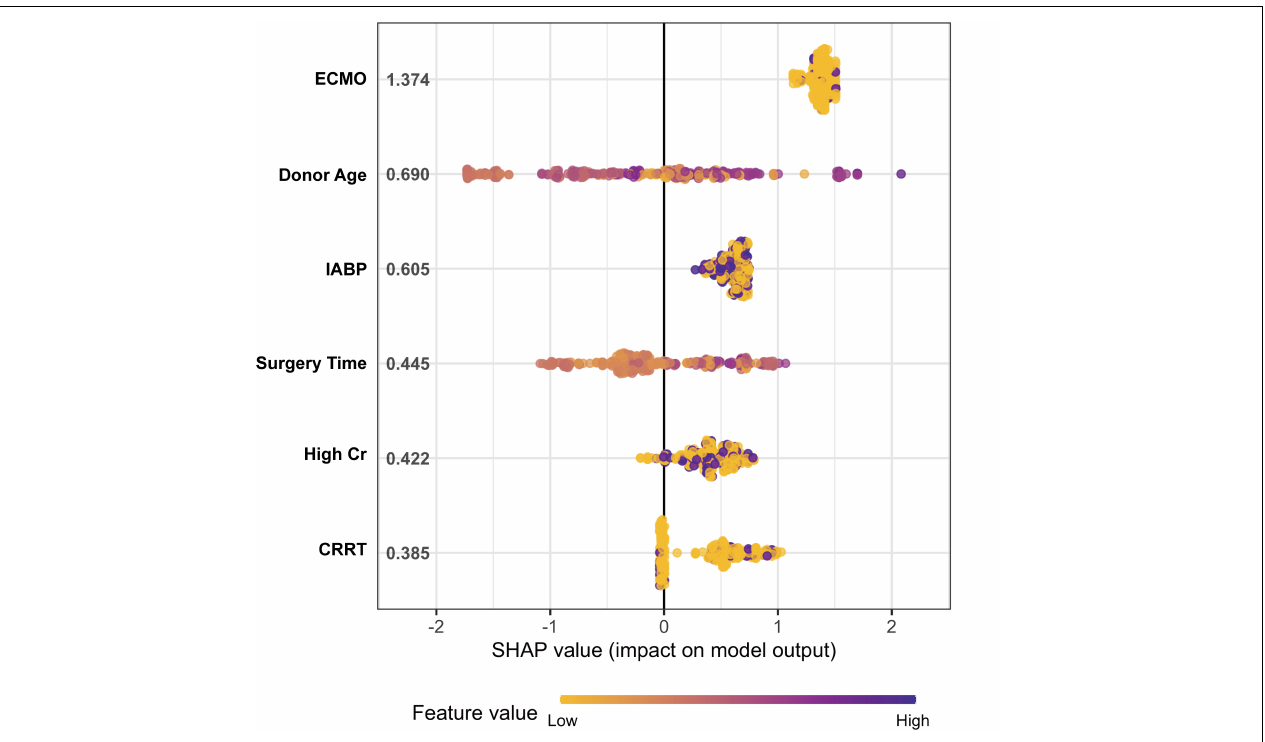
FIGURE 4 | The importance rank and hazard ratio of selected features using SHAP. The importance rank of selected features. Each point in the figure is a feature value of a particular training example. The color of the point represent the feature value and the X-axis position of the point is its SHAP value. The features are ranked by the sum of SHAP value magnitudes over all